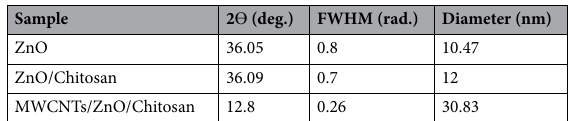
Table 1. Comparison of particle size of the applied photocatalyst samples.